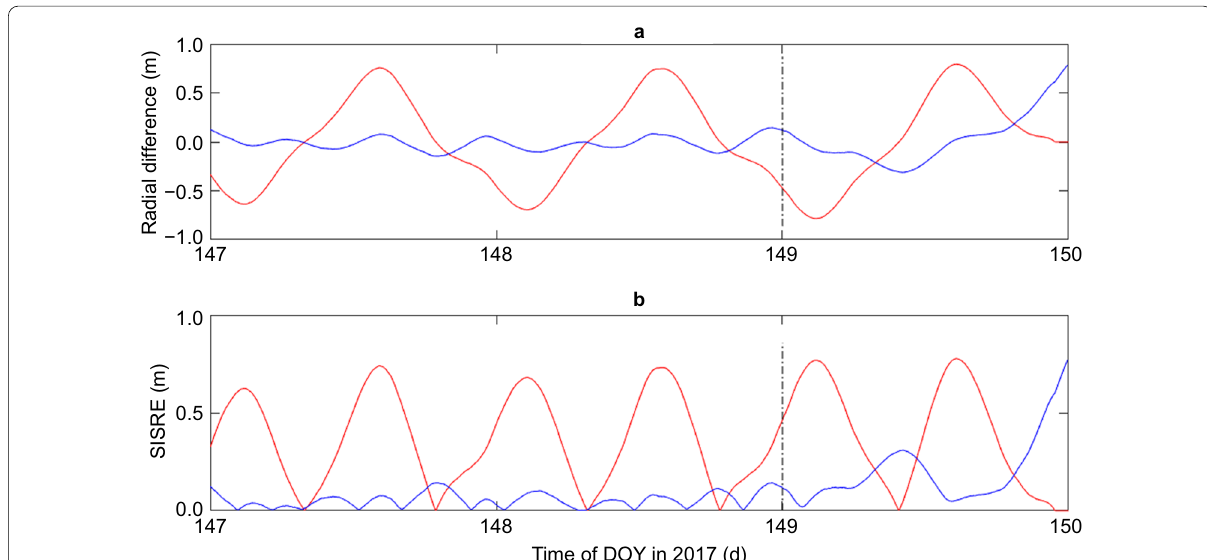
Fig. 5 Upper: orbit radial difference of C01 between ODTS orbits and reference refined orbits (red line), and between 2-day arc refined orbits and reference refined orbits (blue line), where the 2-day arc refined orbits are predicted for 24-h. Lower: Orbit-only SISRE values of C01 using the ODTS orbits in red, and those using the refined 2-day arc orbits in blue